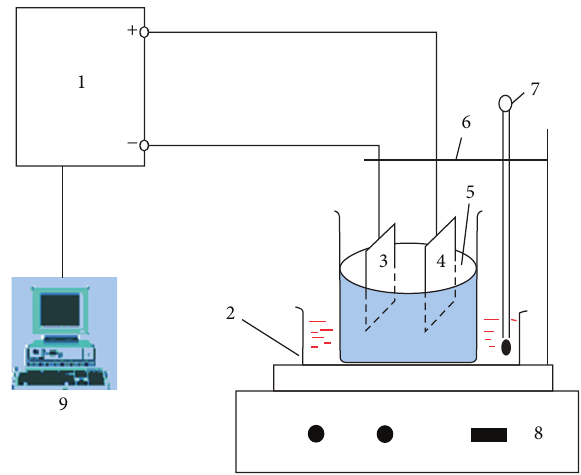
Figure 1: Schematic diagram of DC electrochemical deposition device. (1) Electrochemical workstation, (2) constant temperature water bath, (3) the cathode substrate, (4) graphite anode, (5) elec- trolyte solution, (6) bracket, (7) node thermometer, (8) thermostat magnetic stirrer, and (9) computer.